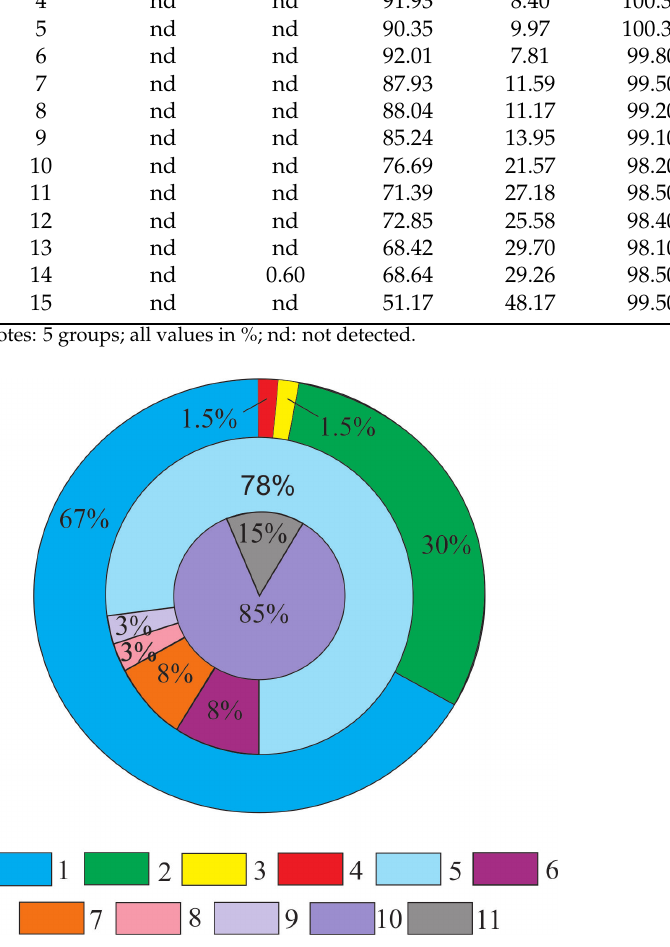
Figure 3. The main typomorphic features of the Billyakh river basin gold: 1–4—granulometric composition: 1—<0.2 mm, 2—0.2–0.5 mm, 3—0.5–1 mm, 4—1–2 mm; 5–9—fineness: 5—951–999‰ (very high- fineness ), 6—950–900‰ (high- fineness ), 7—800–899‰ (medium– fineness ), 8—700–799‰ (relatively low- fineness ), 9—400–699‰ (low- fineness ); 10–11—morphology: 10—lamellar and scaly, 11—slightly rounded gold.